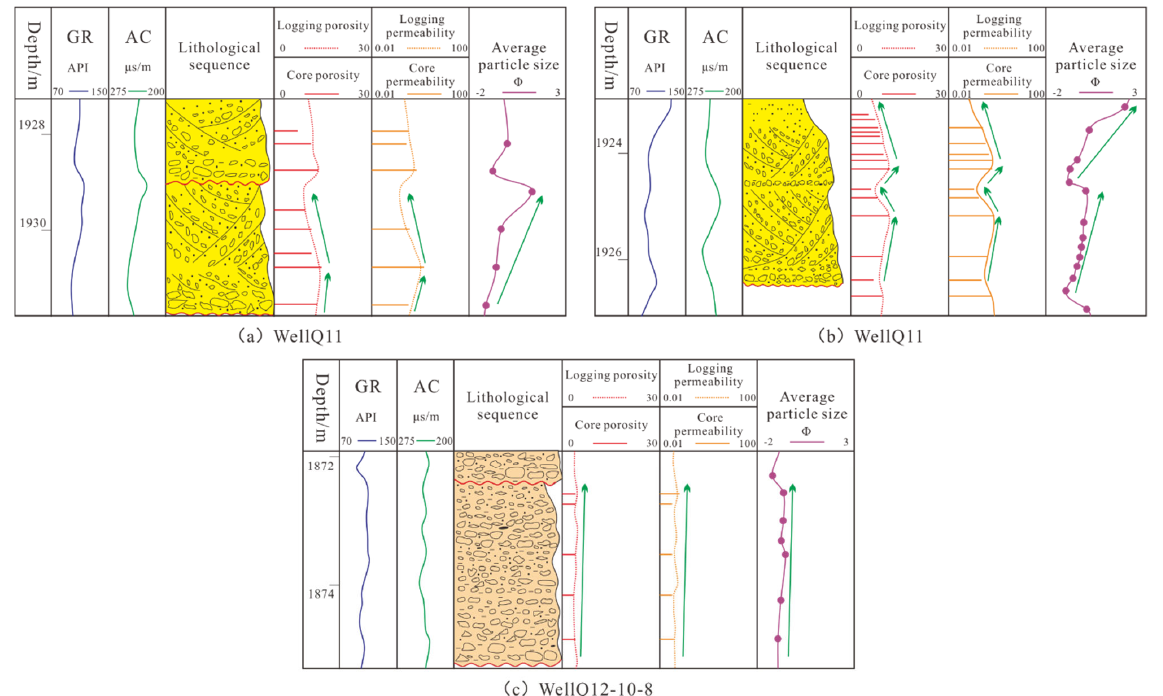
Figure 5. Rhythm characteristics of the Qie12 block in the Kunbei oilfield: ( a ) Well Qie11, 1929–1932 m, single-granularity positive rhythm; ( b ) Well Qie11, 1923.0–1926.5 m, composite permeability rhythm; ( c ) Well Qie12 − 10 − 8, 1872–1875 m, homogeneous rhythm.